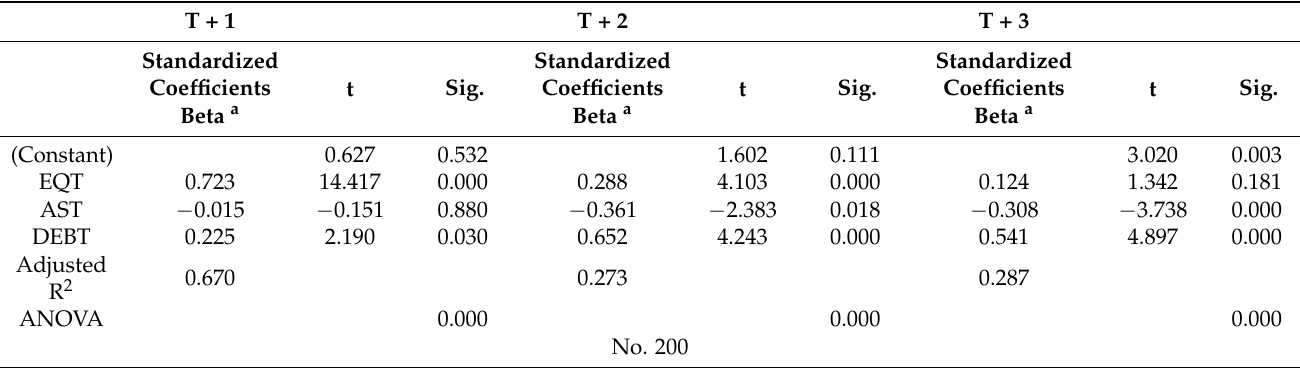
Table 2. Statistics of IPO capital expenditure.